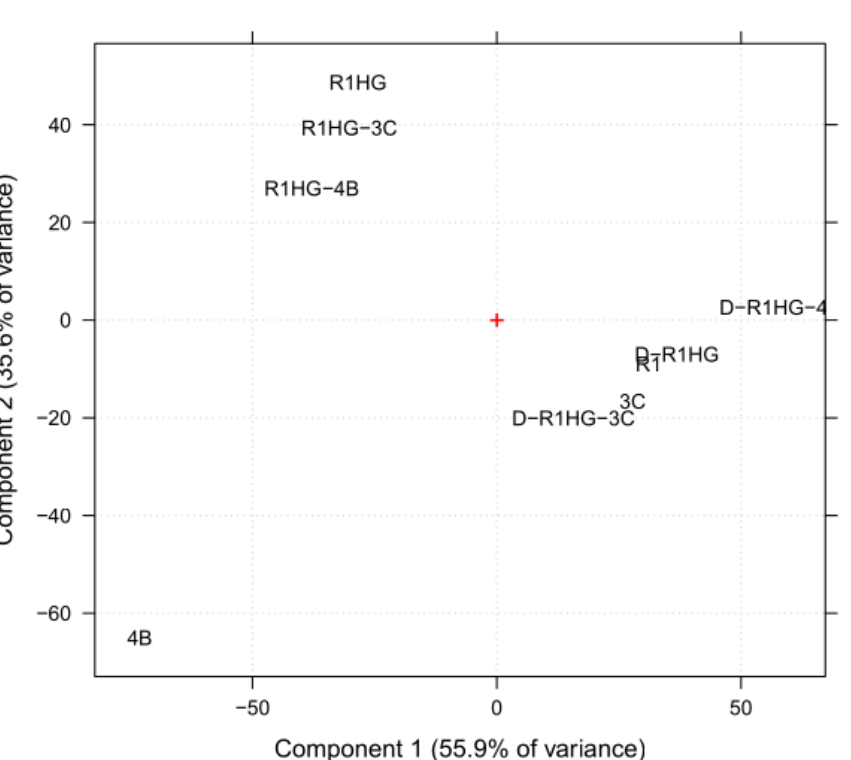
Figure 8. ATR-FTIR spectra of D-R1HG-3c and D-R1HG-4b. Principal Components Analysis (PCA) of the ATR-FTIR Data